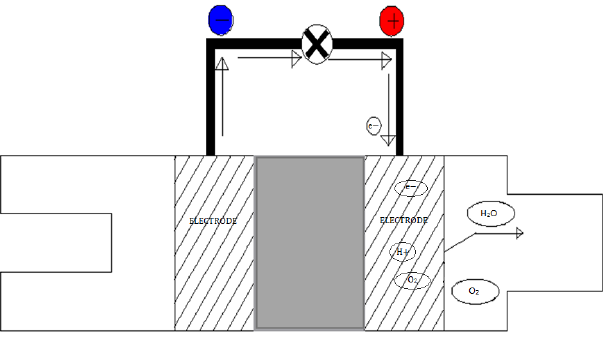
Figure 3. Reverse diagram powering the connected device II (Own study).